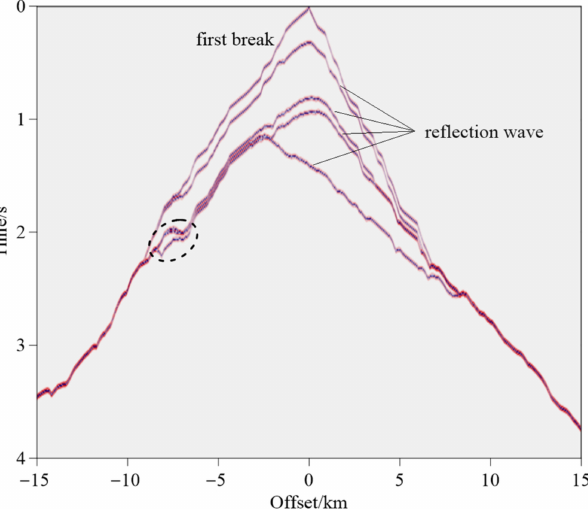
Figure 18. Synthetic seismic gathers. The black circle represents the reflection gathers of the potential geothermal